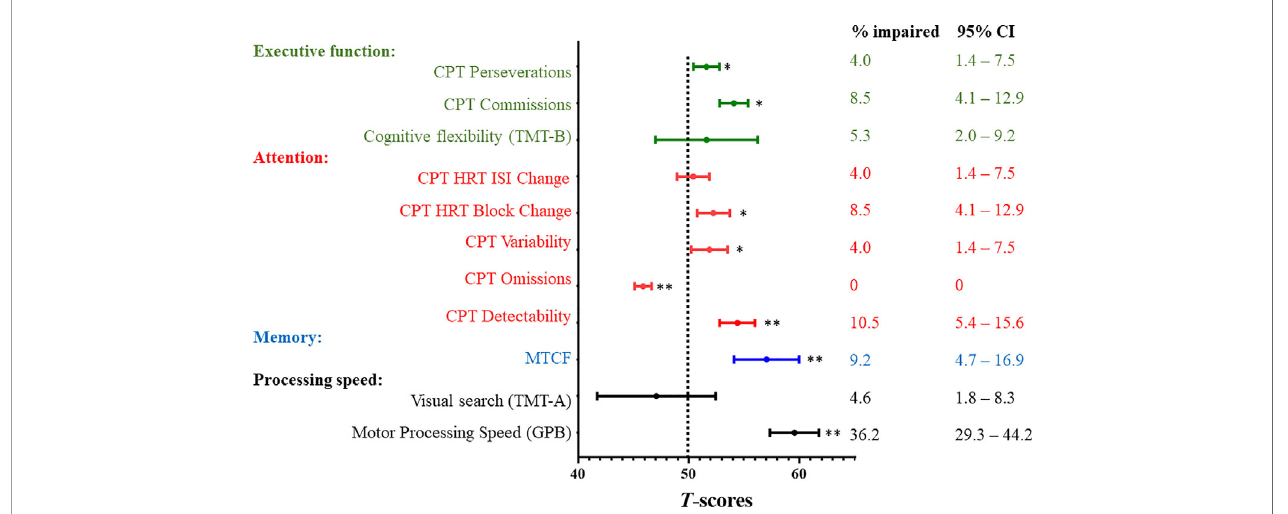
FIGURE 1 | Neurocognitive Outcomes and Prevalence Rates of Impairment. CI, con fi dence interval; CPT, Conners Continuous Performance Test-III; GPB, Grooved Pegboard; HRT, hit reaction time; ISI, inter-stimulus Intervals; MTCF, Modi fi ed Taylor Complex Figure; SD, standard deviation; TMT, Trail Making Test. All neurocognitive measures were transformed into age-adjusted T -scores (mean = 50; standard deviation [SD] = 10) using references provided by the test manuals or the published literature ( Supplement 1 ). All T -scores were scaled such that a higher score was indicative of worse functioning. A one-sample t test was used to compare the survivors ’ performance with population norms (Dotted line; T -score = 50). * indicates statistical signi fi cance at P ≦ 0.05 after correcting for false discovery rate ** indicates statistical signi fi cance at P ≦ 0.01 after correcting for false discovery rate To estimate the prevalence of impairments within the study sample, impairment was de fi ned as a score below the 1.5 standard deviation poorer than the age-adjusted T -scores of reference norms. Prevalence estimates are expressed as proportion (%) and 95% con fi dence intervals.